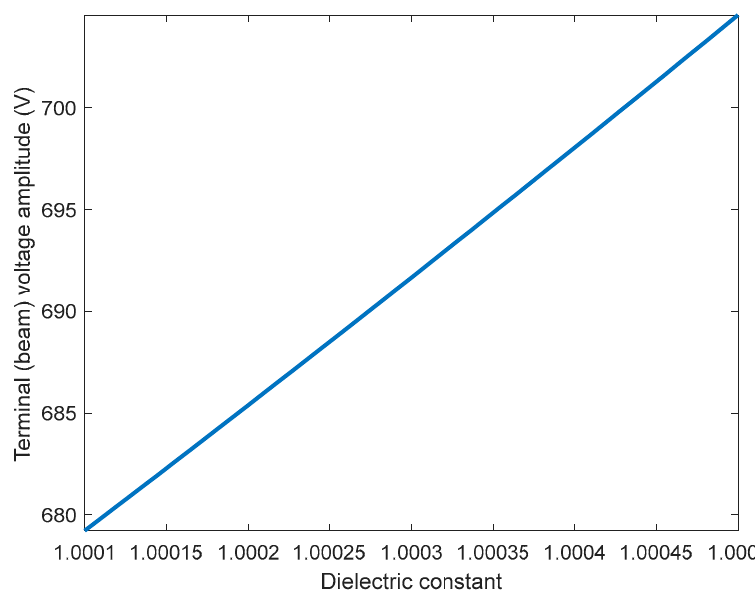
Figure 8. The relationship between the dielectric constant and the terminal voltage amplitude at 3.78 MHz, the reduced voltage range based on ε reduced the sensor’s performance.